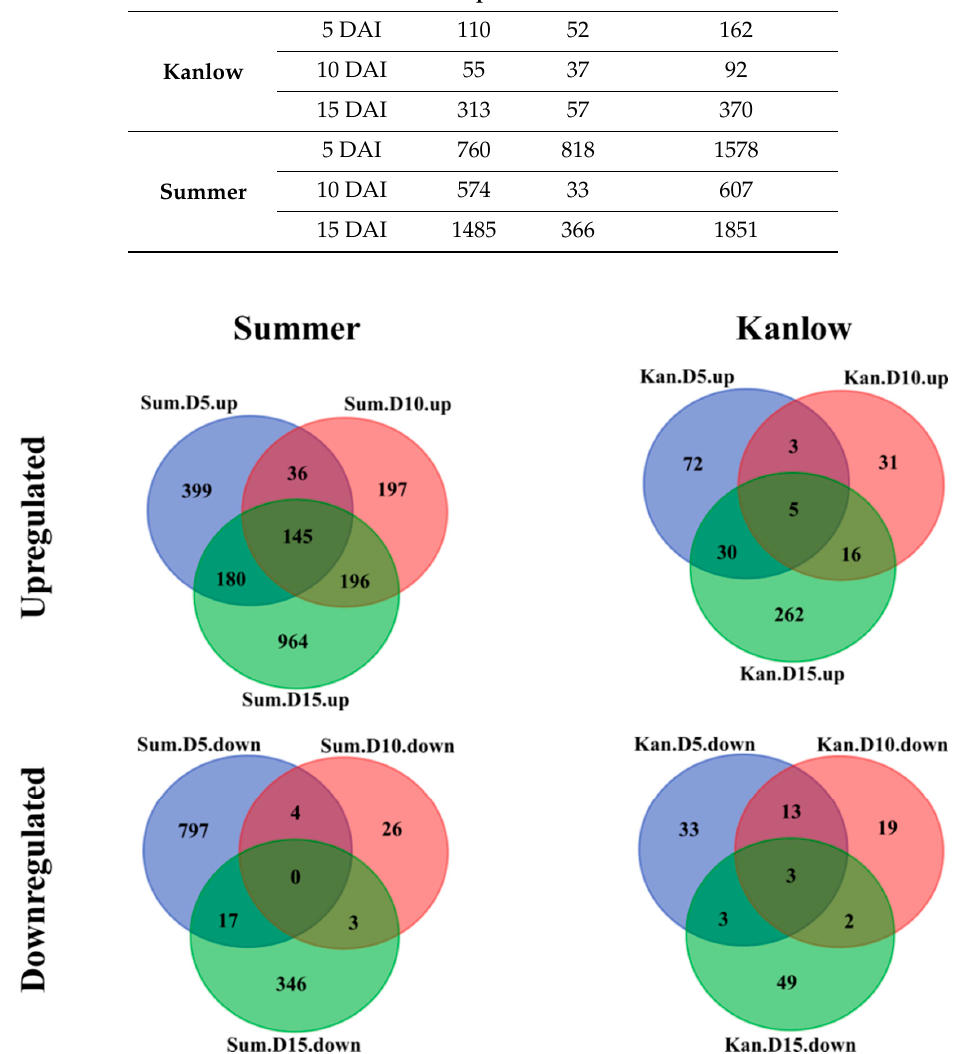
Figure 4. Global changes in differentially expressed genes (DEGs) across time points for each cultivar . Global changes in DEGs are shown as Venn diagrams. Summer DEGs are in the left panel and Kanlow DEGs in the right panel. DEGs are represented for each cultivar between the three time points: 5 Days After Infestation (DAI) (blue), 10 DAI (red), and 15 DAI (green). Only zero and three genes were downregulated at all three time points for Summer and Kanlow, respectively (Figure 4, lower panel). Among the three genes downregulated in Kanlow, only one has a putative functional characterization related to “cytochrome P450, family 71, subfamily B, polypeptide 13”. The same comparison was performed to identify the overlapping DEGs between the two cultivars at each time point (Figure 5). Between 20 to 177 upregulated genes were induced in common between the two cultivars in response to YSA infestation. These genes represent 36 to 62% of the upregulated genes in Kanlow and 9 to 12% of the upregulated genes for Summer (Figure 5, top panel). At 5 DAI (69 genes upregulated in common) and 15 DAI (177 common genes) have functions related to “flavonoid biosynthesis”, “metabolomics pathways”, “phenylpropanoid biosynthesis”, “biosynthesis of secondary metabolites”, and “plant – pathogen interaction” (Supplemental Table S4). Interestingly, the Arabidopsis EGL3 homologous copy ( Pavir.7KG285720 ) has been found upregulated in Summer and Kanlow for the three time points. The low number of genes upregulated in common at 10 DAI (20 genes) did not allow reliable functional enrichment analysis. Similarly, one to five downregulated genes that overlapped between the two genotypes at each time point (Figure 5, lower panel) were not functionally classified.